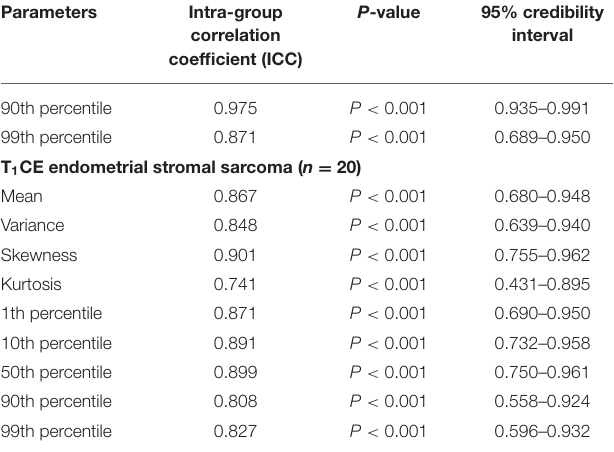
TABLE 3 | Consistency or correlation test for different parameter values between two